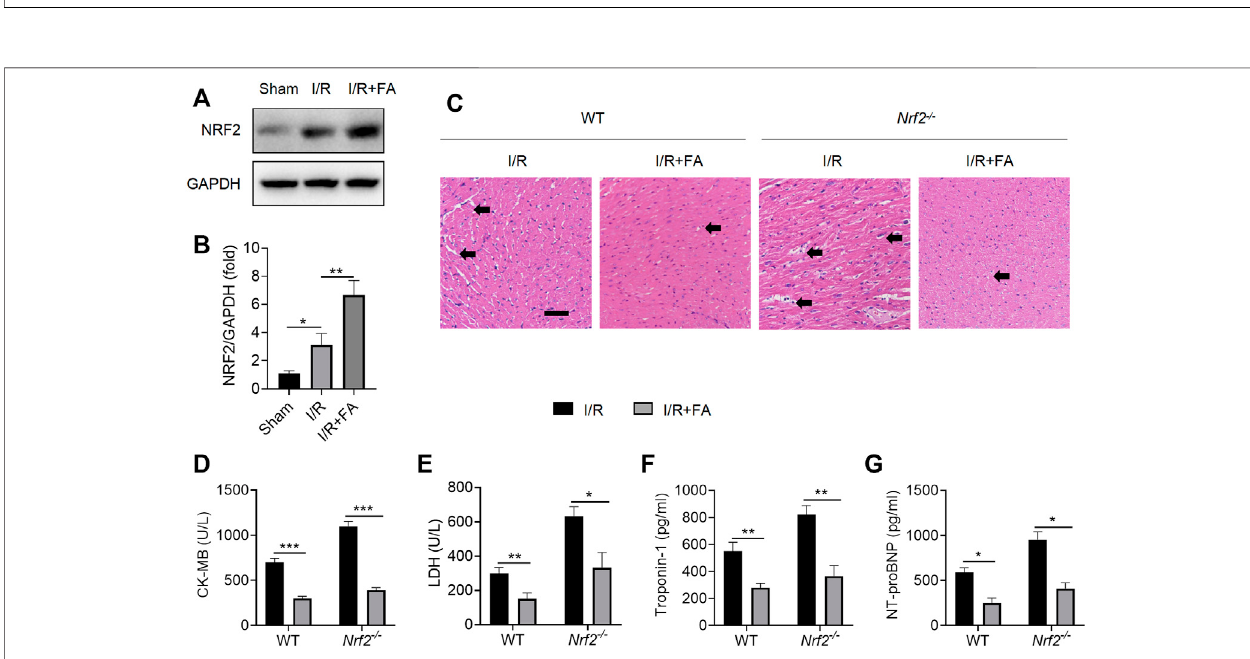
FIGURE5| FAinducesanincreaseinNRF2,butNRF2knockoutdoesnoteliminatethemyocardialprotectiveeffectofFA. (A,B) TheexpressionofNRF2proteinin eachgroupofWTmicewasdetectedbywesternblotting. (C) HEstainingresultsofhearttissuesectionsinWTmiceand Nrf2 − / − miceineachexperimental group. (D – G) Expression of CK-MB, LDH, troponin-1, and NT-proBNP in the serum of each experimental group in WT mice and Nrf2 − / − mice . Data are expressed as the means ± sd from three independent experiments or are representative of three independent experiments. * p < 0.05, ** p < 0.01, and *** p < 0.001.